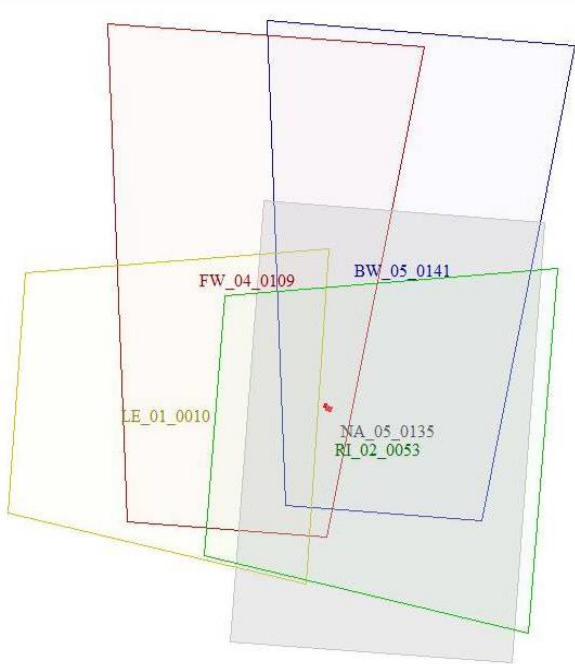
Figure 4. Image footprints of five Osprey Prime cameras on AVT building (indicated in red) in adjacent flight strips.